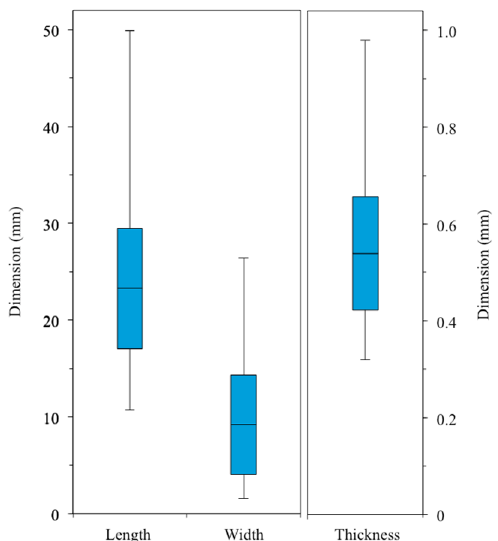
Figure 5. Size distributions in length, width, and thickness of wafers in form of box ‐ whisker ‐ plots, where the mean as horizontal line, the standard deviation as a box, and minimum and maximum values as whiskers (length and width measurement n = 433; thickness measurement n = 388).